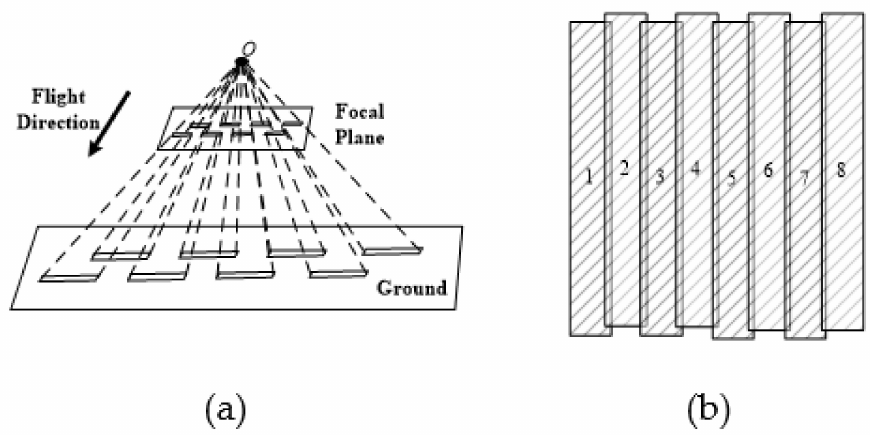
Figure 3. The ground coverage diagram of the spliced satellite optical camera at the imaging moment. ( a ) The instantaneous imaging diagram; ( b ) Ground coverage of each